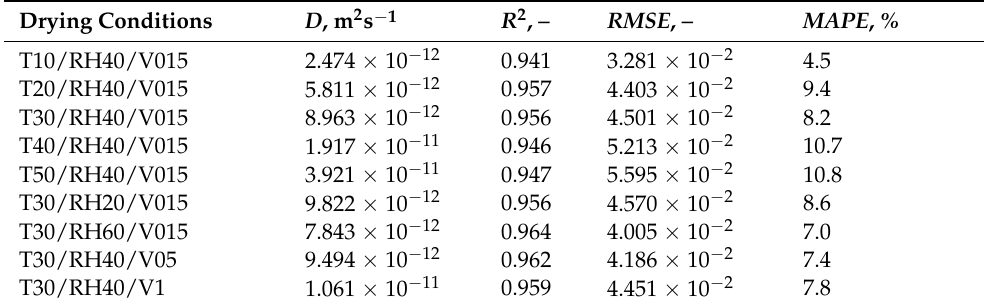
Table 3. Effective moisture diffusion coefficients D for short times (1 ≤ X* ≤ 0.2) depending on the drying conditions ( T , RH , v ) and statistical results ( R 2 , RMSE , MAPE ). Drying Conditions D , m 2 s −